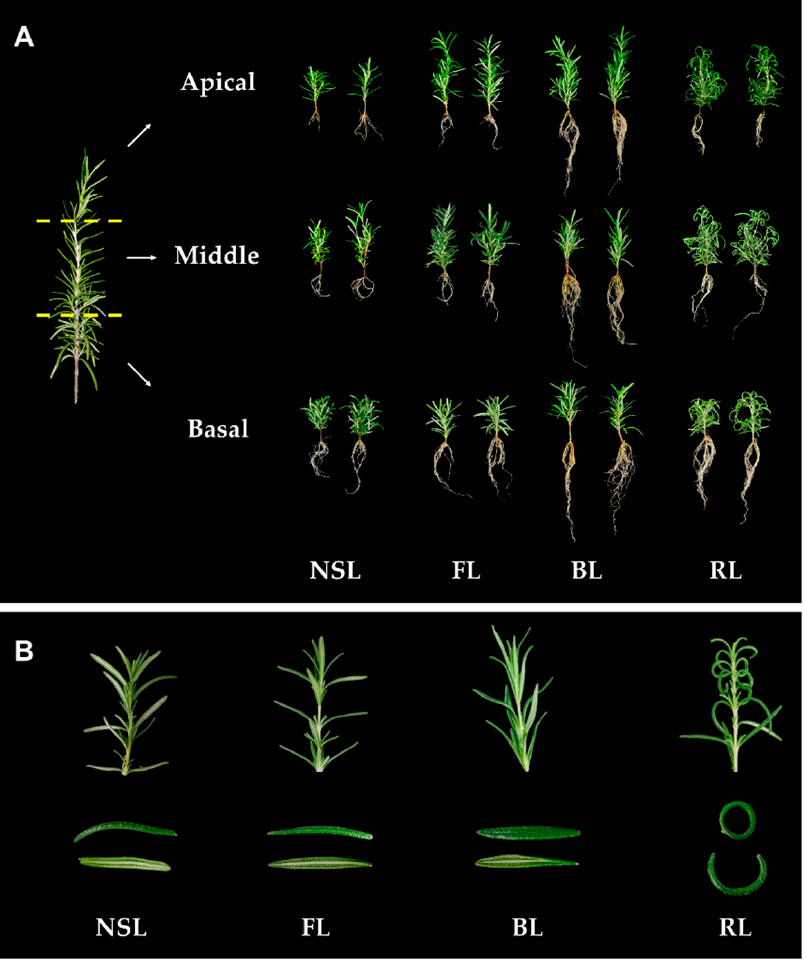
Figure 1. ( A ) Morphological differences in apical, middle, and basal rosemary cuttings irradiated by different light sources—natural sunlight (NSL), fluorescent lamp light (FL), blue light (BL), and red light (RL)—at 4 weeks. ( B ) Morphological changes of young leaves on apical cuttings.